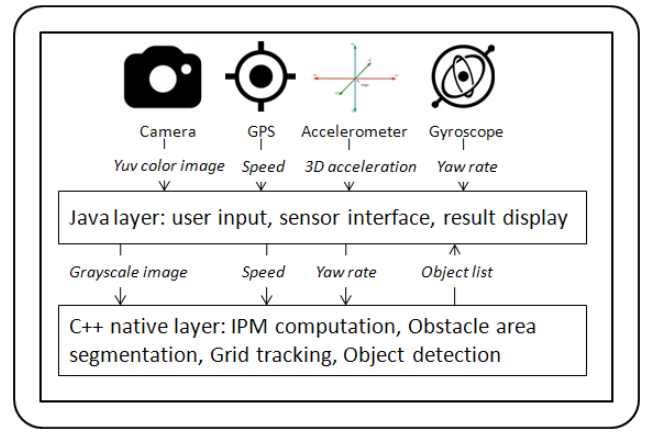
Figure 10. Architecture of the solution.